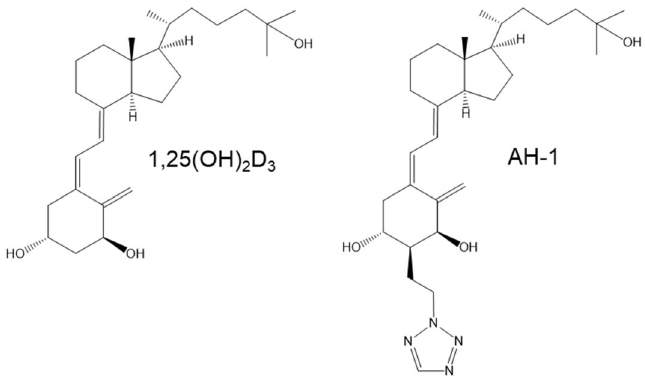
Figure 1. Chemical structures of 1,25(OH) 2 D 3 and